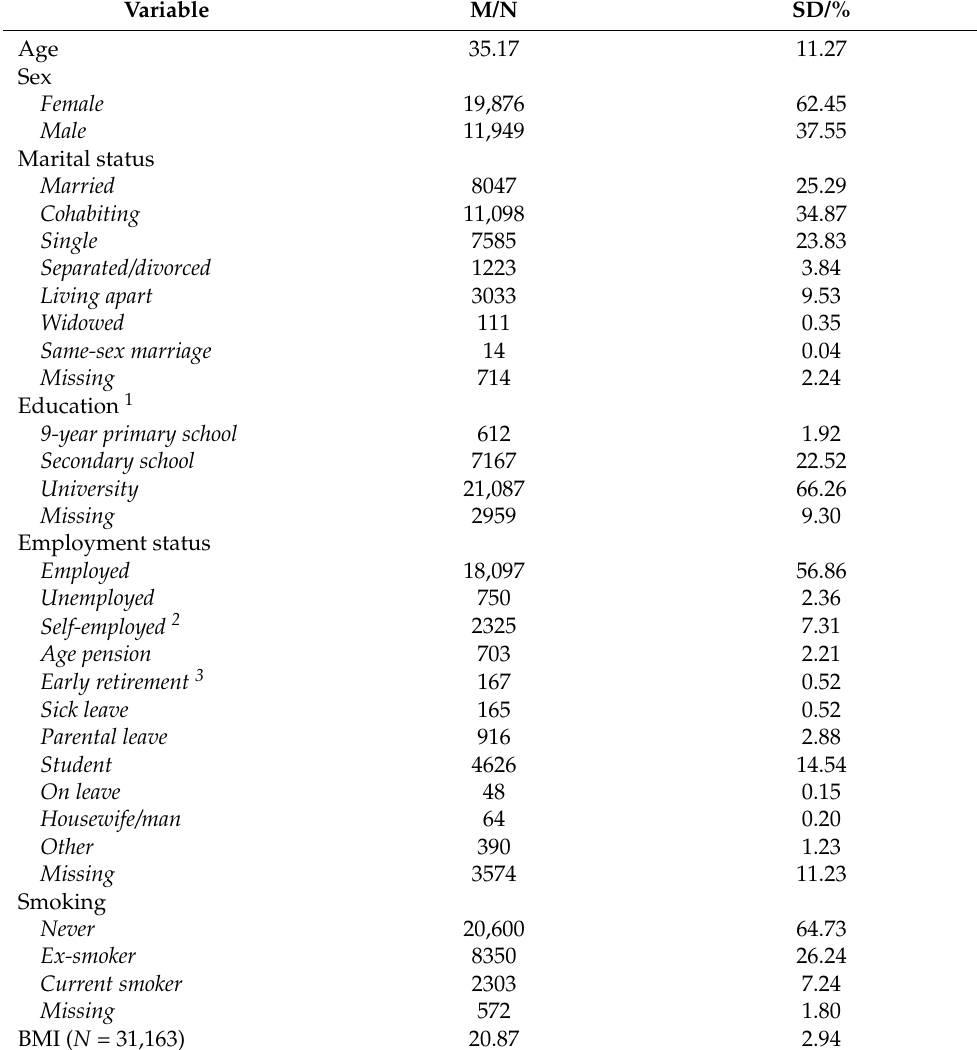
Table 1. Sample characteristics ( N =